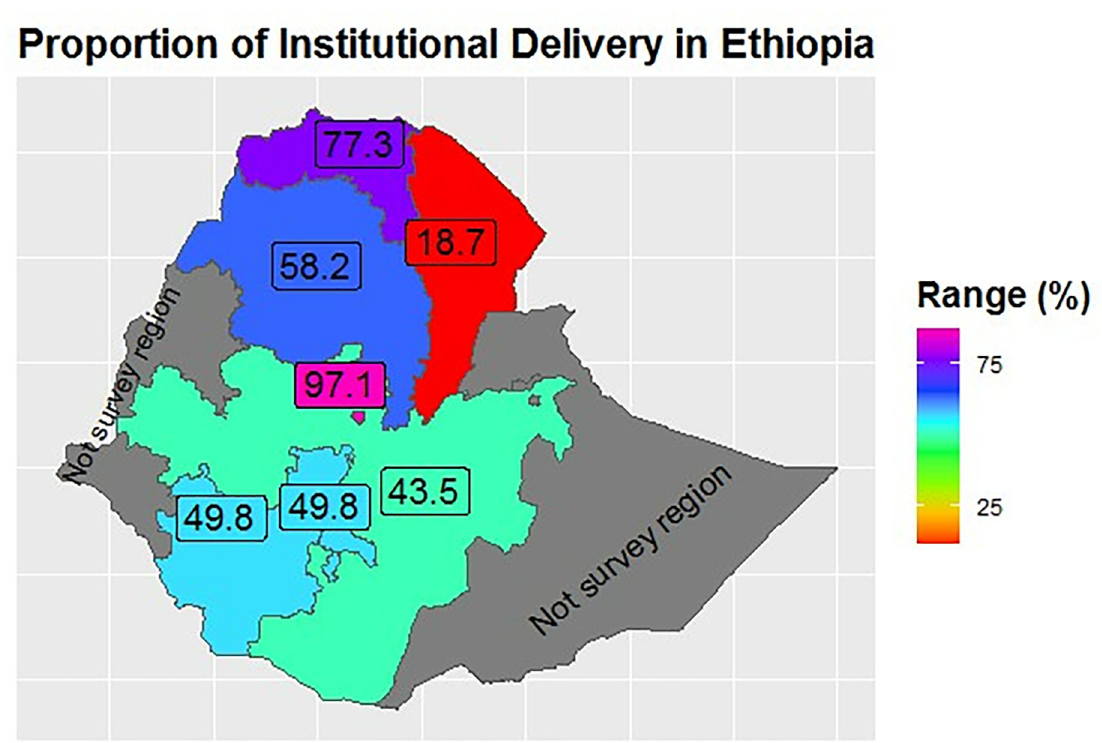
Fig 1. Proportion of institutional delivery at different regions in